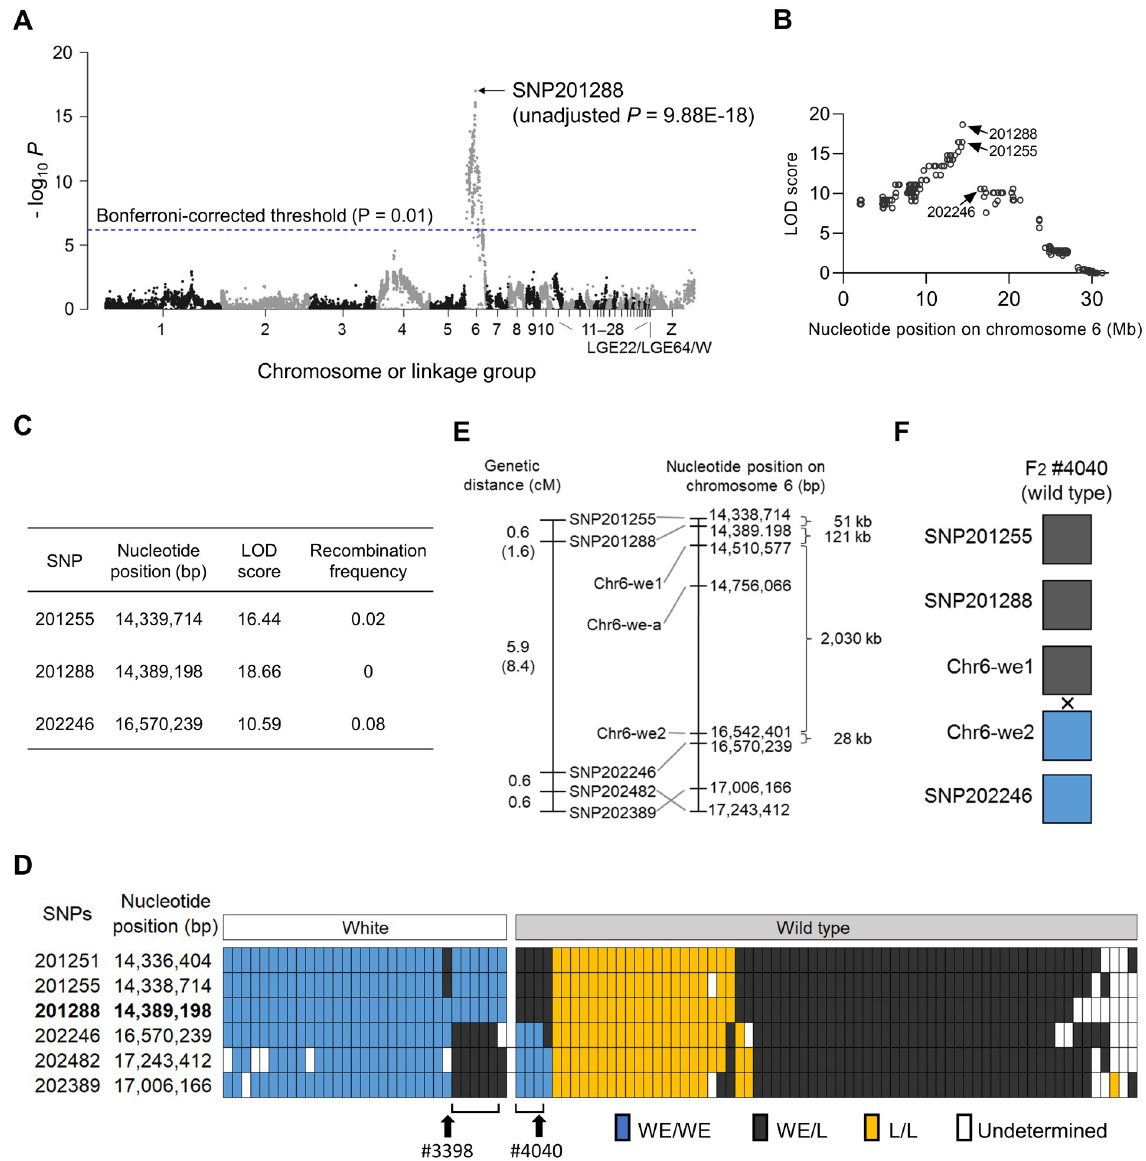
Fig 3. Genetic linkage mapping of the we locus. (A) Association test using 15,200 single nucleotide polymorphism (SNP) markers. x -axis, genomic coordinates of SNPs; y -axis, negative logarithm of p -values from Fisher’s exact test. Blue line indicates the Bonferroni-corrected p- value of 0.01. SNP201288 displayed the strongest association with the phenotype. (B) Logarithm of the odds (LOD) scores between the we locus and all SNP markers on chromosome 6. SNP201288 and flanking SNPs (SNP201255 and SNP202246) display high LOD scores. (C) LOD scores and recombination frequencies of three SNPs near the we locus. (D) Genotypes of SNPs near the we locus in 99 F 2 individuals. SNP201288 shows a complete concordance between the genotypes and eggshell colors in the F 2 progeny. Discordance between the genotypes and eggshell colors was observed for SNP201255 in F 2 individual #3398 and for SNP202246 in eight F 2 progeny shown by brackets, including the F 2 individual #4040. (E) Genetic and physical maps of SNP markers around the we locus. Genetic distances between the we locus and flanking markers are indicated by parentheses. Positions of SNP202482 and SNP202389 are inverted between the genetic and physical maps, possibly due to an assembly error in the draft genome. (F) Genotypes of Chr6-we1 and Chr-we2 are concordant and discordant, respectively, with the eggshell color, in the F 2 individual #4040. Recombination in the interval between SNP markers is indicated by “ × ”.